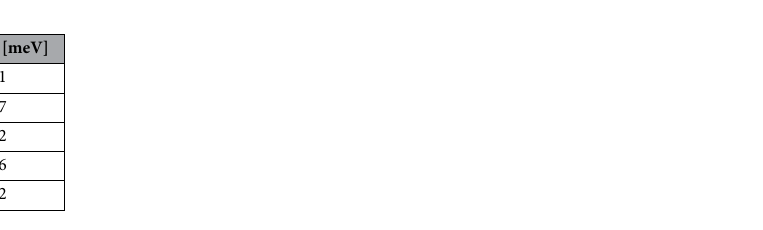
Table 5. Bandgap calculations and Urbach energy of NiO thin films.